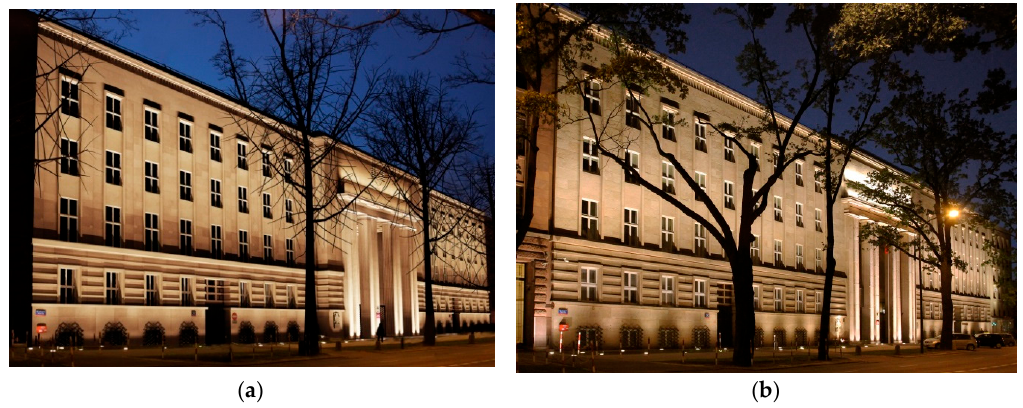
Figure 6. Comparison of: ( a ) computer visualisation of object with ( b ) post-implementation photo of analysed object.